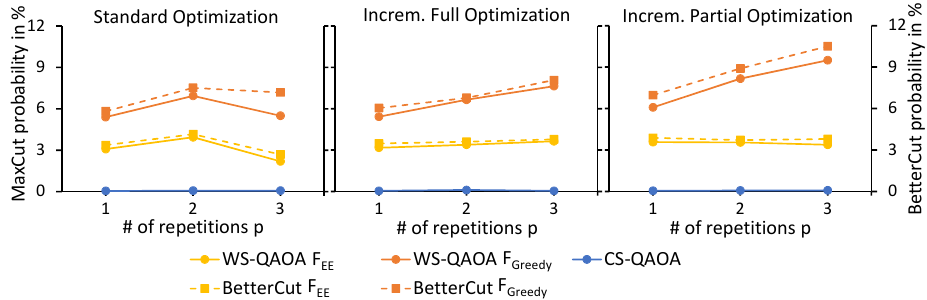
Figure 6. Comparison of the MaxCut and BetterCut probabilities obtained at each p ∈ { 1,2,3 } for each optimization approach and objective functions F EE and F Greedy . WS-QAOA for G 12, fc was warm-started with the initial cut of size 92 (cf. Table 1). CS-QAOA was optimized based on the energy expectation F EE . The values show median probabilities observed in 20